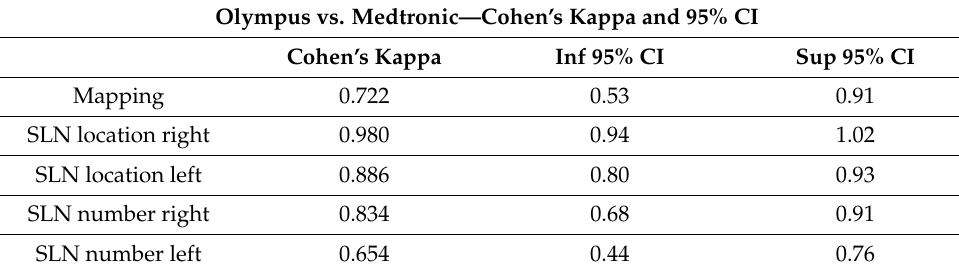
Table 3. Inter-rater reliability for the two near-infrared